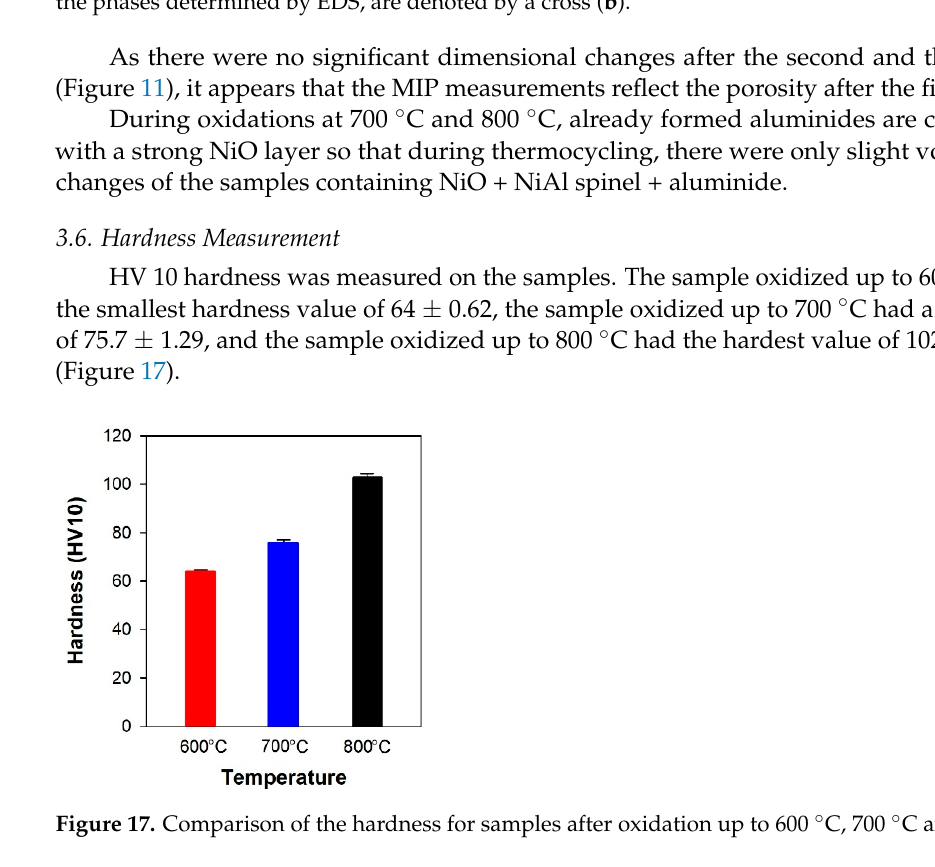
Figure 16. SEM macrostructure of the sample oxidizes at 600 °C after thermocycling in Ar ( a ), with the phases determined by EDS, are denoted by a cross ( b ).